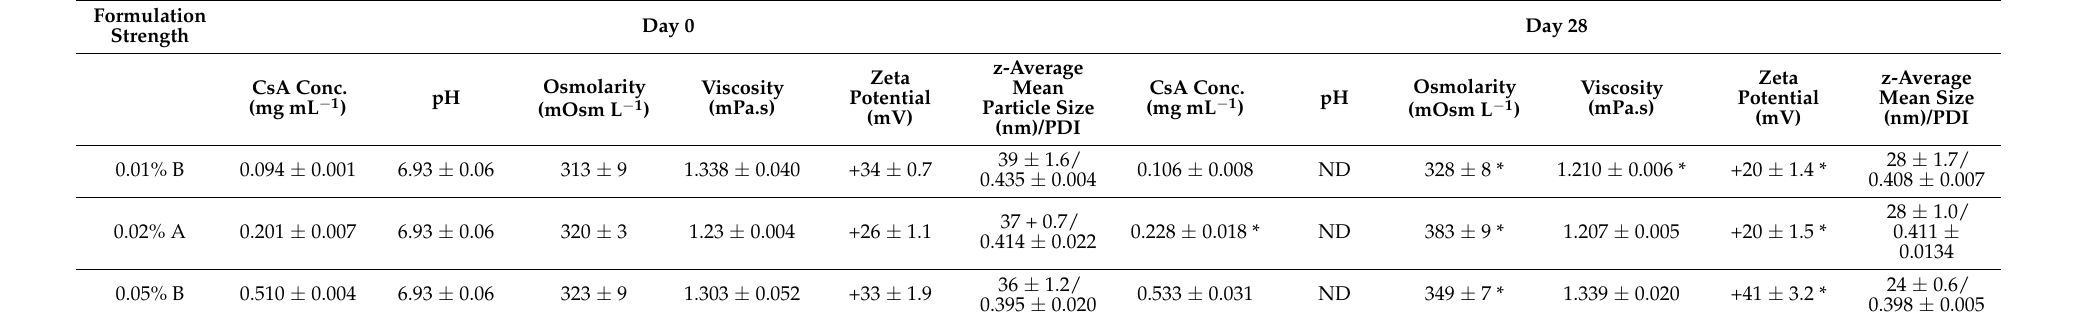
Table 3. NM133 Storage at Elevated Temperature (40 ◦ C), mean ± s.d. from three independent samples.